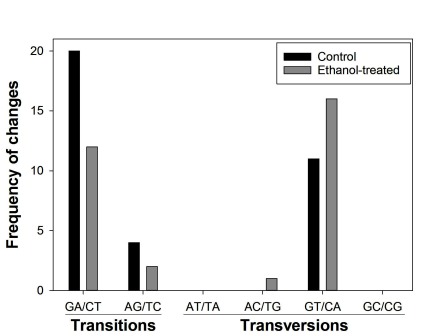
Number of mutations found pooling the CaMV sequences from ethanol-treated and control amiR1-6-3 plants (3 replicates).The number of nucleotides sequenced was 23,436 for control and 24,003 for ethanol-treated plants. Ethanol-treated plants turn on the expression of amiR1-6-3 that was designed to silence the expression of the
AtCDA1 gene.